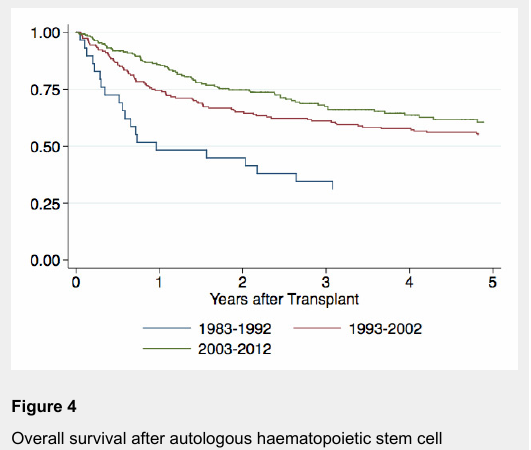
Overall survival after autologous haematopoietic stem cell transplantation